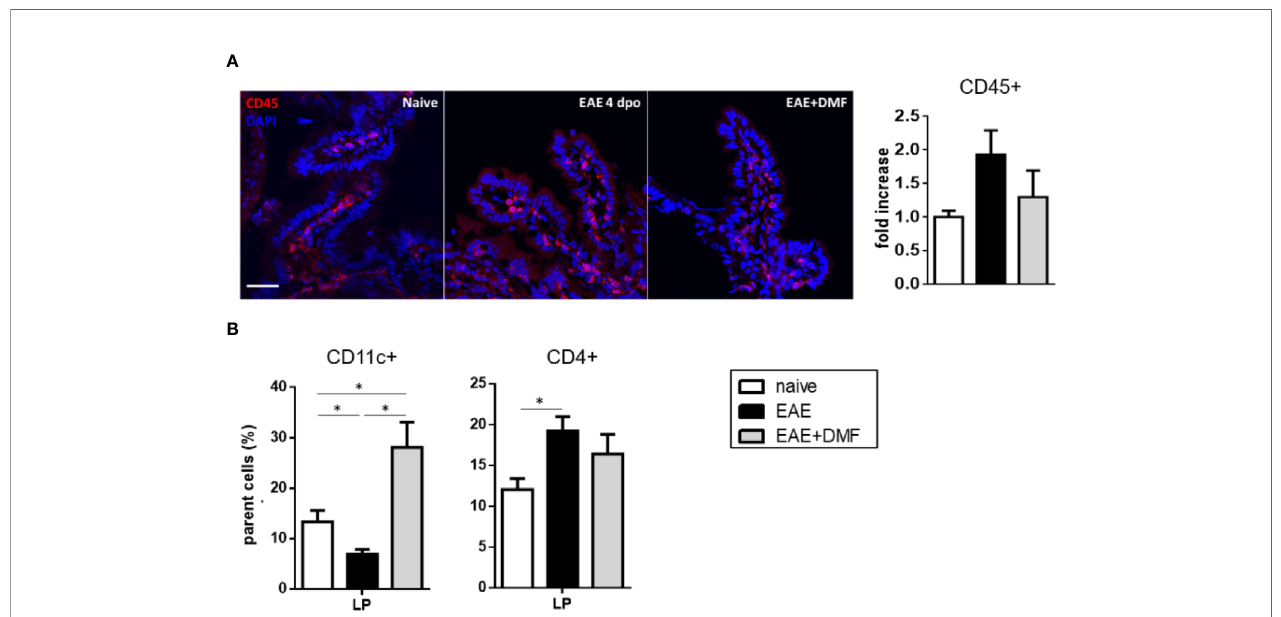
FIGURE 5 | DMF treatment differentially affects the in fi ltrated immune cells in ileum LP of EAE-affected mice. (A) DMF treatment does not signi fi cantly revert the increase in CD45+ cells in ileum LP induced by EAE. Confocal microscopy images of the ileum of naïve and EAE-affected mice treated or not with DMF (left panel) and quanti fi cation of the CD45+ cells (right panel). Slides were stained with anti-CD45 antibody (red) and with DAPI (blue). Scale bar: 50 m m. (B) DMF treatment of EAE-affected mice increases the percentage of CD11c+ cells, but has no effect on the increased CD4+ cell population in the ileum LP. FACS analysis of CD11c+ and CD4+ T cells in LP from naïve mice and at 4 days post onset from EAE-affected mice, treated or not with DMF. Average clinical scores of mice at time of the analysis: WT-EAE-affected mice: 3 ± 0.17; WT-EAE-affected mice treated with DMF: 2.75 ± 0.11. Results are shown as mean ± SEM of at least N = 3 independent experiments, with at least N = 3 mice per group per experiment. * P <